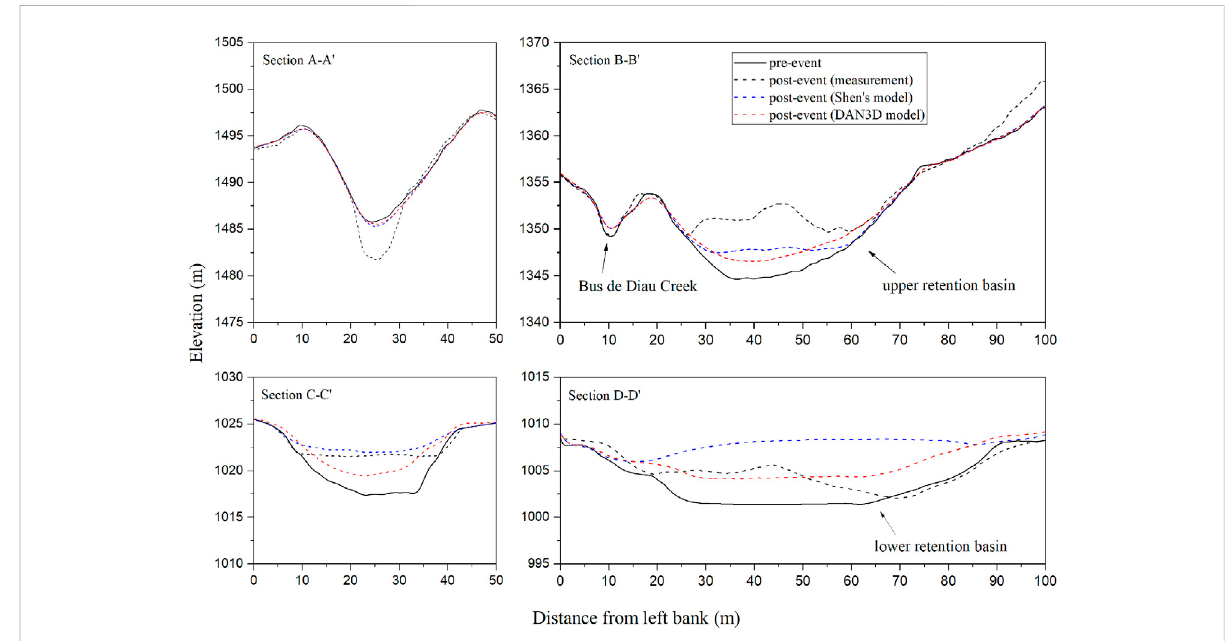
FIGURE 11 Debris fl ow channel cross-section comparing the pre- and post-event morphology (Section location shown in Figure 10C).